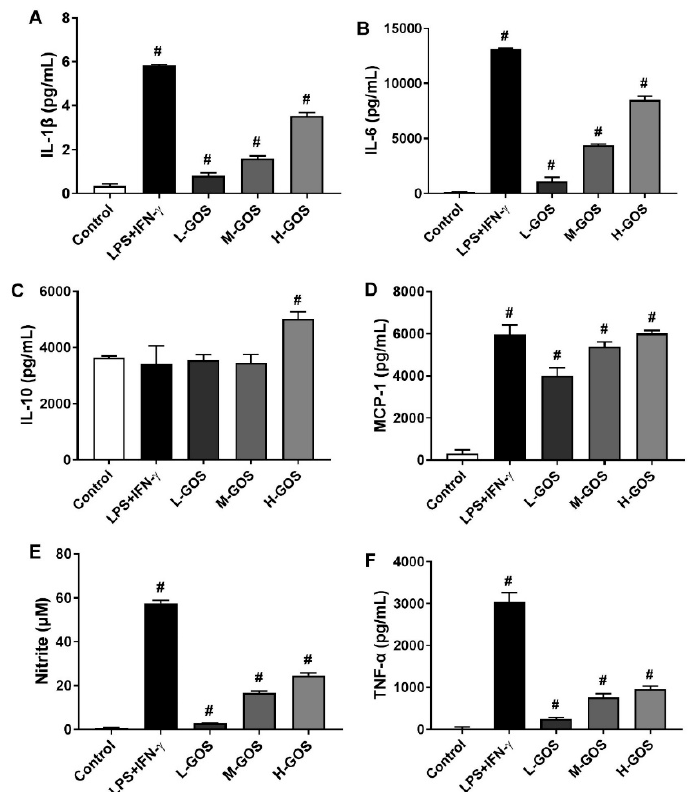
Figure 4. ELISA analysis of GOS (25 − 100 µg/mL) induced cytokine production of IL-1 β ( A ), IL-6 ( B ), IL-10 ( C ), MCP-1 ( D ), and TNF- α ( F ), as well as the release of nitrite ( E ) in BMDMs. # —Indicated significant difference versus the control group at p < 0.05.